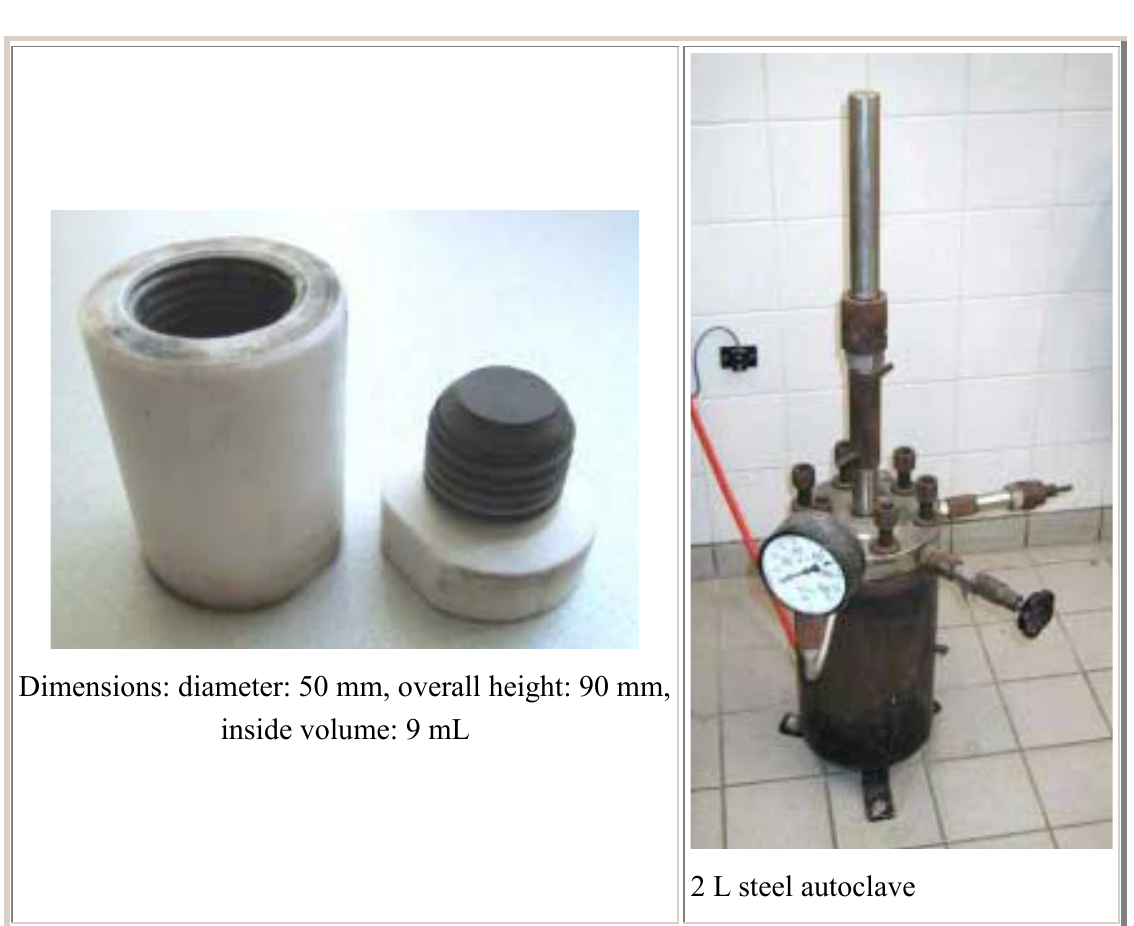
Figure 1b : Autoclaves used in the experiments